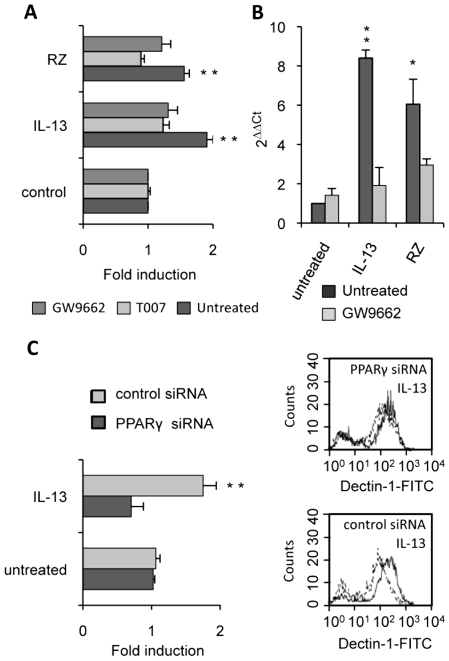
PPARγ inhibition in M2 polarized macrophages abolishes the increase of Dectin-1.(A) The protein level of Dectin-1 on peritoneal macrophages was measured by flow cytometry after treatment with IL-13 (50 ng/mL) or rosiglitazone (RZ) (5 µM) in the presence of the PPARγ antagonists (GW9662 (5 µM) and T007 (2 µM)). Data are the means±SE of three separate experiments. (B) Dectin-1 mRNA level of peritoneal macrophages was quantified by quantitative real-time RT-PCR after treatment with IL-13 (50 ng/mL) or rosiglitazone (RZ) (5 µM) in the presence of the PPARγ antagonist (GW9662 (5 µM)). Data are the means±SE of three separate experiments. ** (p<0.01) and * (p<0.05) indicates a significant difference compared with the untreated macrophages. (C) The surface protein level of Dectin-1 on peritoneal macrophages transfected with siRNA targeting PPARγ (PPARγ siRNA) or control siRNA (control siRNA) and stimulated by IL-13. Representative Dectin-1 FACS profiles of untreated (unfilled histograms) and treated (filled histograms) macrophages were obtained by flow cytometry. The changes in Dectin-1 receptor levels were normalized to the untreated macrophages transfected with the siRNA control. Data are the means±SE of three separate experiments. ** (p<0.01) and * (p<0.05) indicates significant difference compared with the untreated macrophages transfected with the siRNA control.